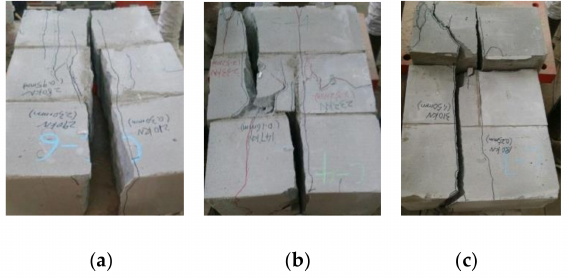
Figure 6. Compressive failure of the block masonry: ( a ) central crack; ( b ) unsymmetrical crack; ( c ) eccentric